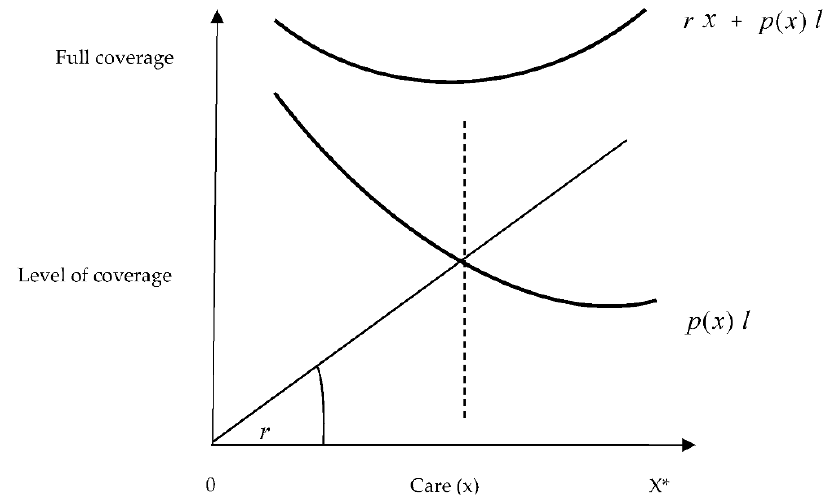
Figure 2. Optimum level of coverage.